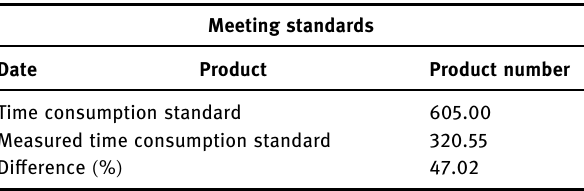
Table 2: Comparison of company ’ s standard and